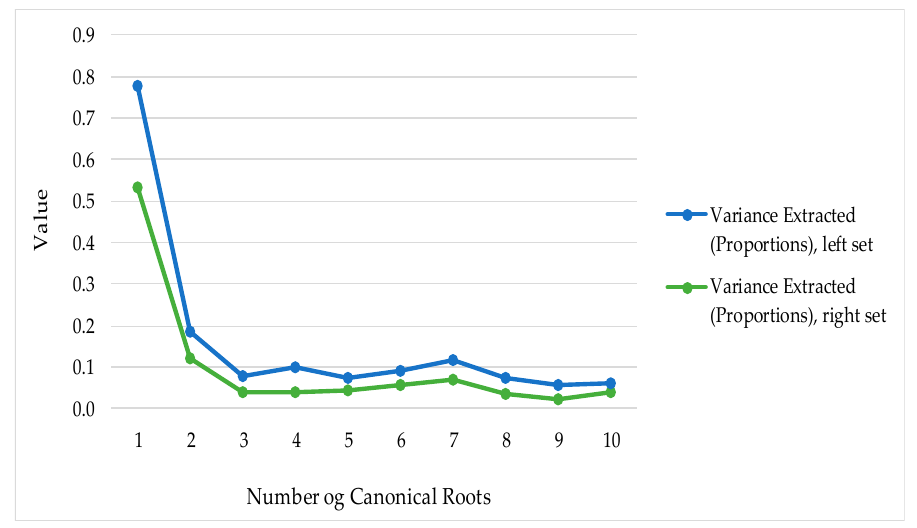
Figure 3. Canonical variable scattering plot.